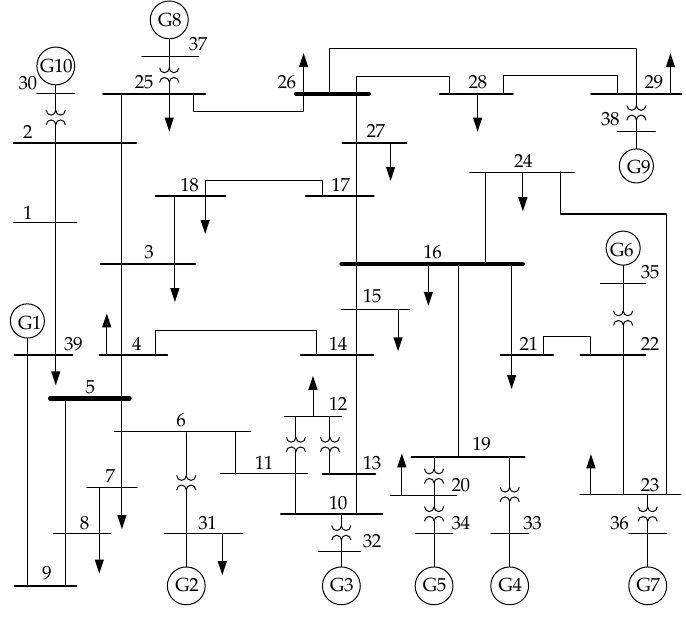
Figure 3. New England 39 ‐ bus system.